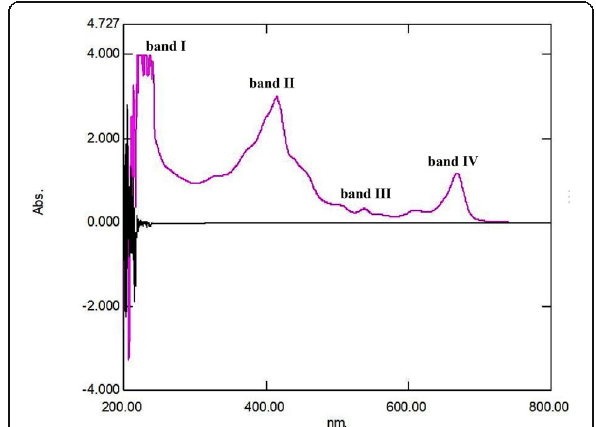
Fig. 2 UV-visible spectrum of methanolic extract of Andrographis paniculata whole plant